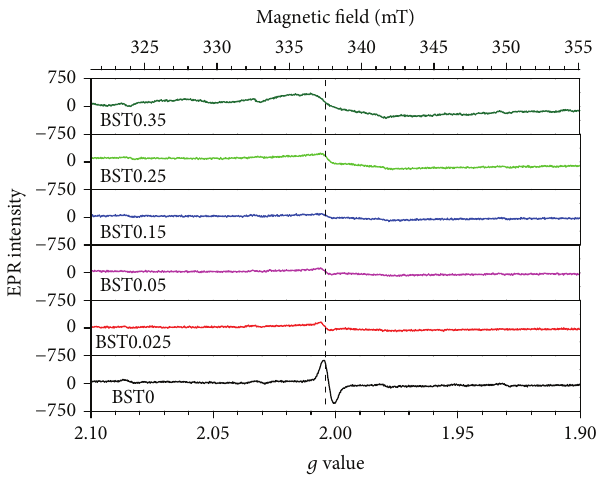
Figure 5: The EPR signal of BST powders with various Na contents.